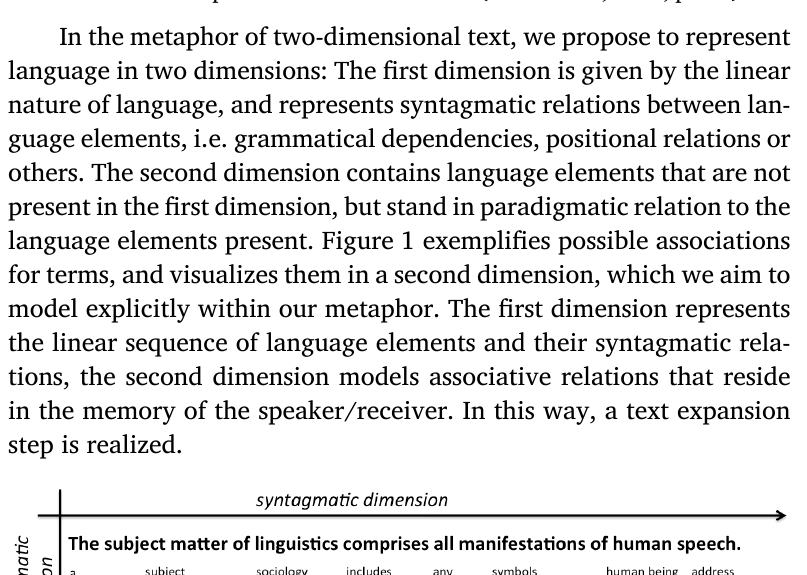
Figure 1: Exemplification of the metaphor of two-dimensio- nal